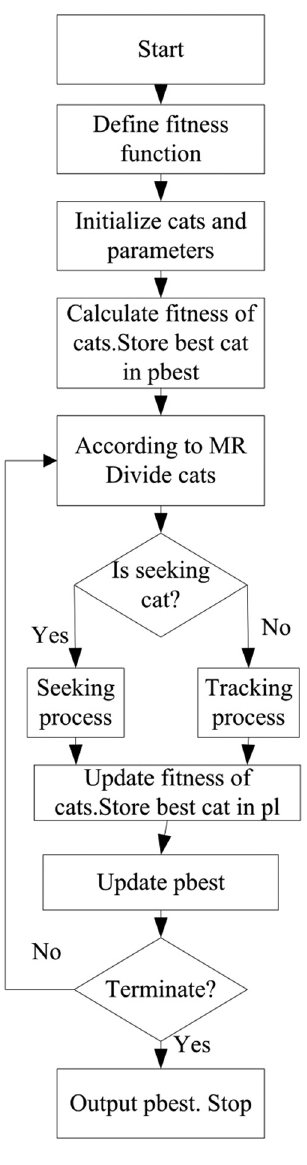
Figure 1: CSO fl